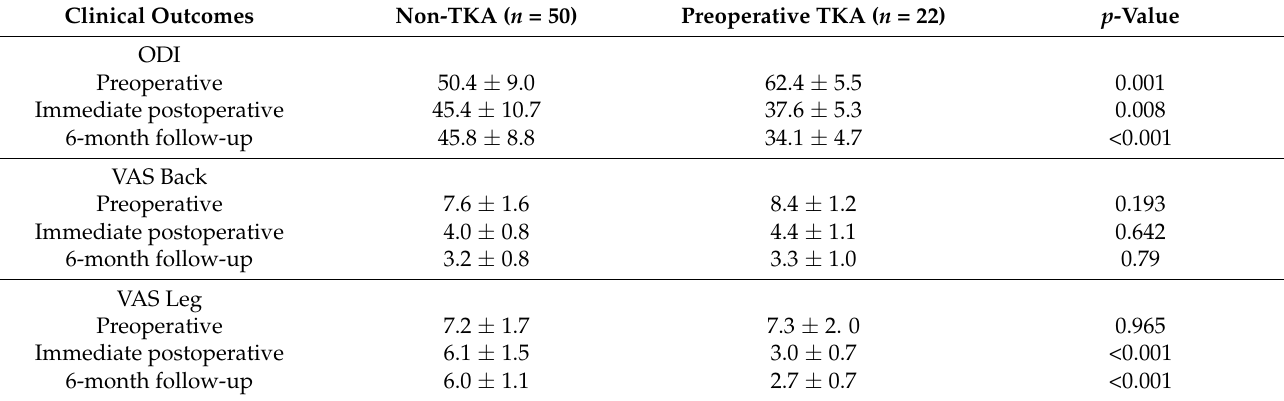
Table 4. Comparison for clinical outcomes between spinal fusion only and preoperative TKA with spinal fusion. Clinical